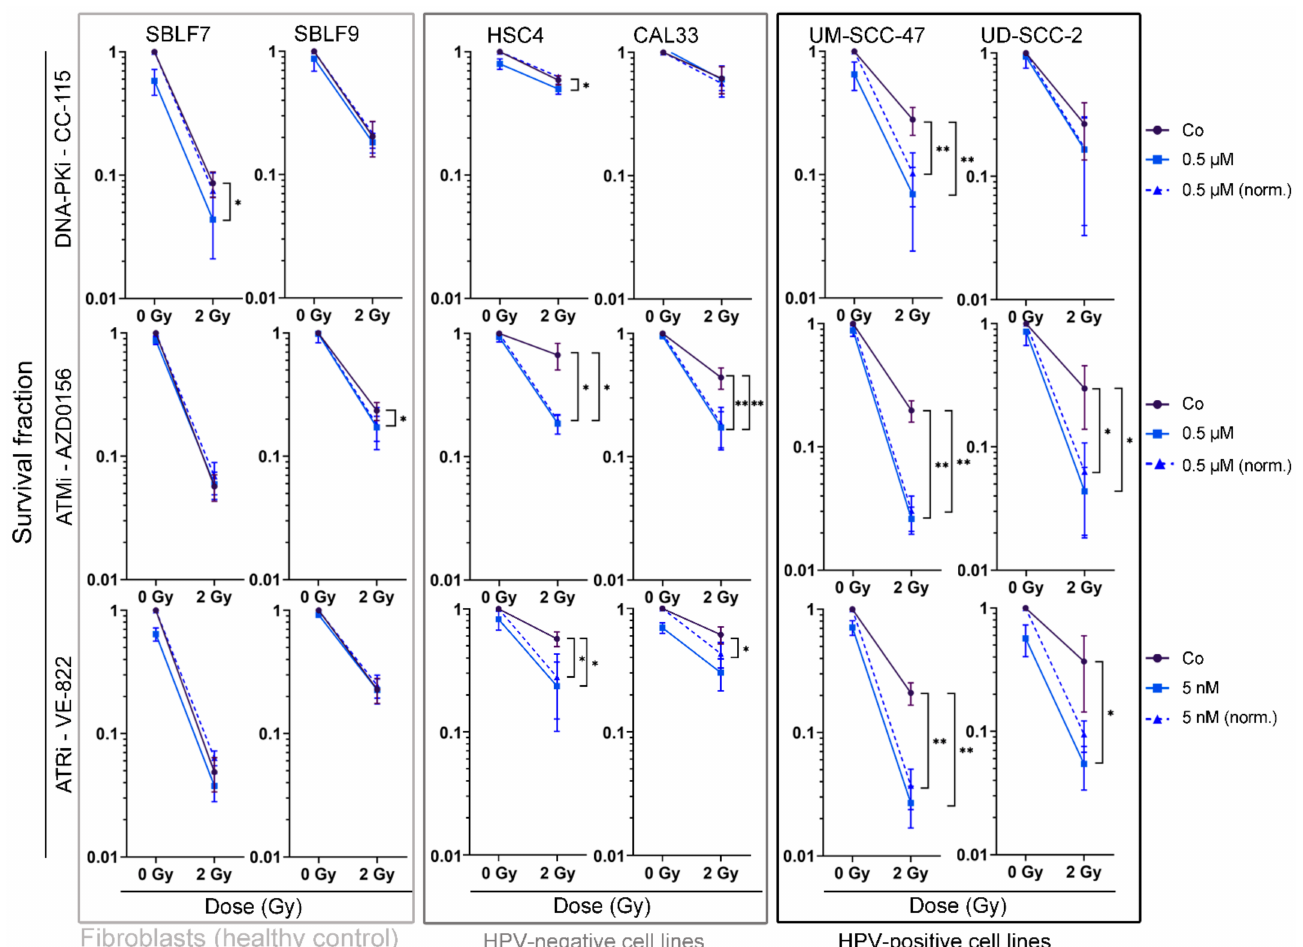
Figure 4. Colony forming assay of HNSCC cell lines and normal controls. Cells are shown grouped into normal cells (SBLF7, SBLF9) and HPV-negative (HSC4, CAL33), and HPV-positive (UM SCC 47, UD SCC 2) HNSCC cells. Graphs show cell survival at 0 Gy and 2 Gy, either with additional treatment of kinase inhibitors (0.5 µ M CC 115, 0.5 µ M AZD0156, 5 nM VE-822) or without. Additionally, cell survival under KI treatment was normalized to detect synergistic effects. Dashed line represents mean survival fraction normalized to the cytotoxicity induced by KI alone. Each value represents mean ± SD ( n ≥ 3). Significance was determined by one-tailed Mann Whitney U test * p ≤ 0.05 and ** p ≤ 0.01. p = 0.004: UM SCC 47 + CC 115, UM SCC 47 + CC 115 norm., UM SCC 47 + AZD0156, and UM SCC 47 + AZD0156 norm.; UM SCC 47 + VE 822 and UM SCC 47 + VE 822 norm.; p = 0.008: CAL33 + AZD0156 and CAL33 + AZD0156 norm.; p = 0.028: CAL33 + VE 822 norm.; p = 0.016: SBLF9 + AZD0156; p = 0.018: UD SCC 2 + AZD0156 and UD SCC 2 + AZD0156 norm.; p = 0.028: UD SCC 2 + VE 822; p = 0.050: HSC4 + VE 822, HSC4 + VE 822 norm., SBLF7 + CC-115; p = 0.050: HSC4 + CC 115, HSC4 + AZD0156 and HSC4 + AZD0156